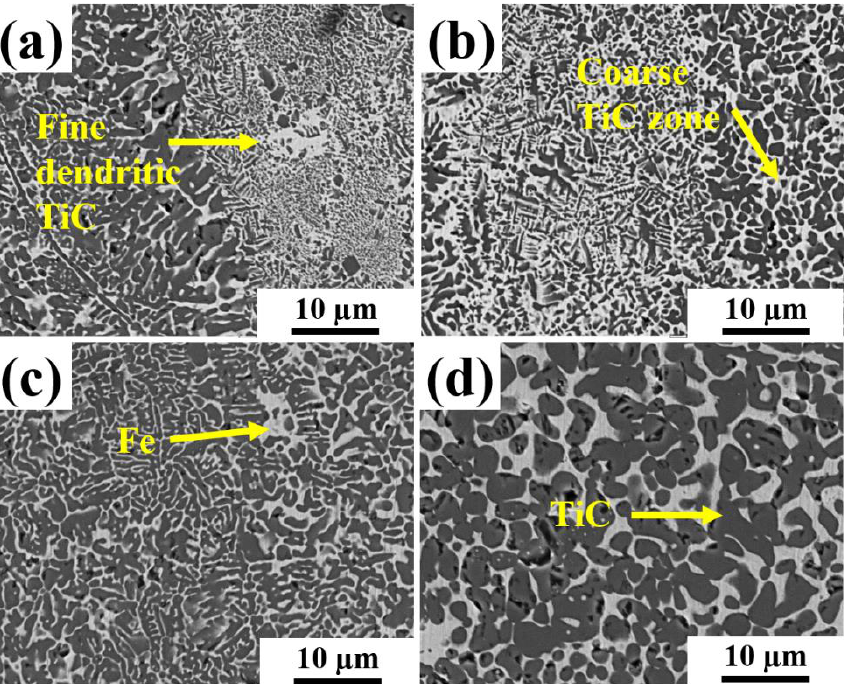
Figure 6. High magnification microstructures of the as-built cermets showing characteristic mor- phology of the TiC along the longitudinal section with different laser melting peak power for pulse shaping. ( a ) LMP50, ( b ) LMP60, ( c ) LMP70, and ( d ) LMP84.